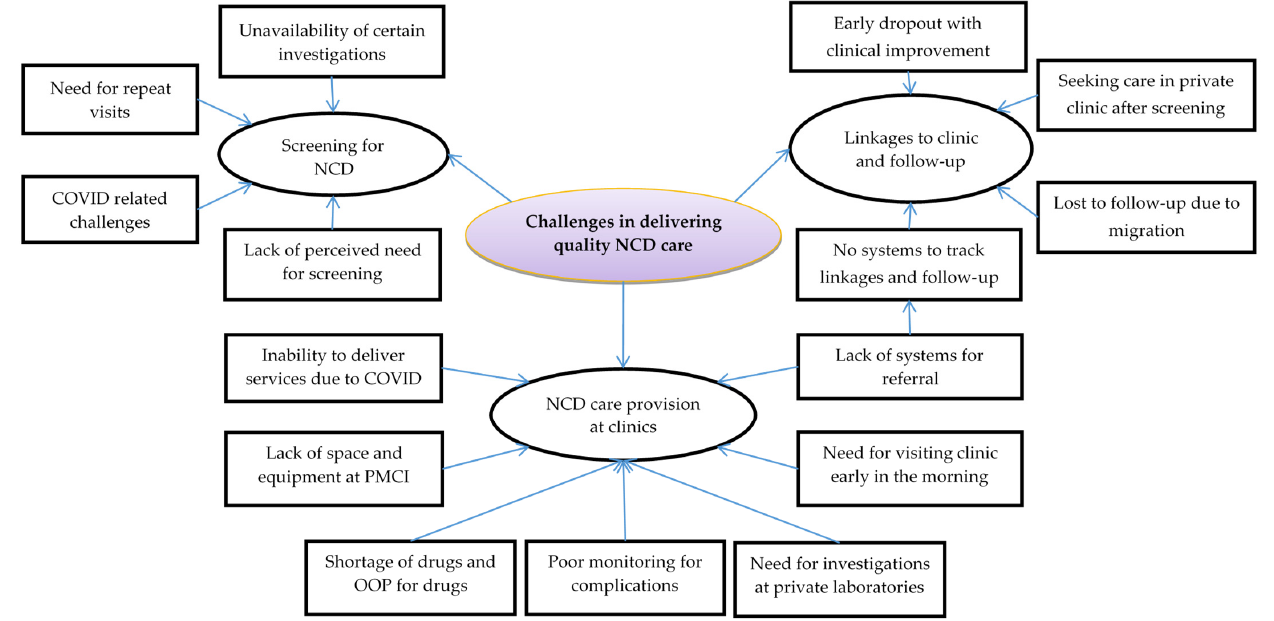
Figure 2. Challenges in delivering quality NCD care in the PMCIs supported by PSSP in Sri Lanka, 2021. Abbreviations: NCD: noncommunicable disease; PMCI: primary medical care institution; PSSP: Primary Healthcare System Strengthening Project; OOP: out-of-pocket expenditure.